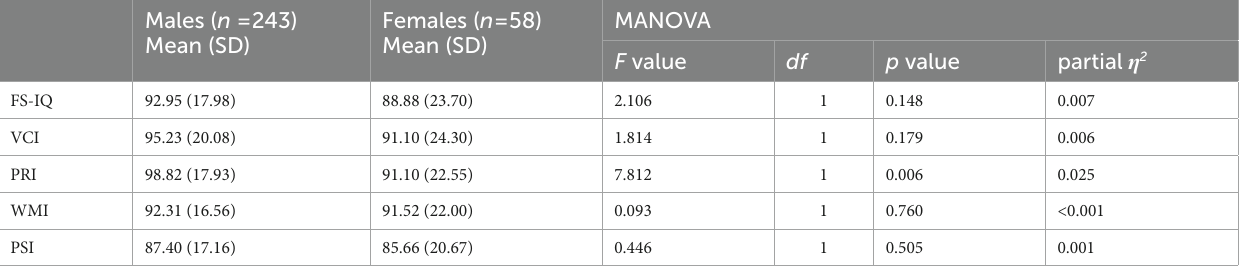
TABLE 1 Test of the between-subjects effect of sex on the intelligence of children with